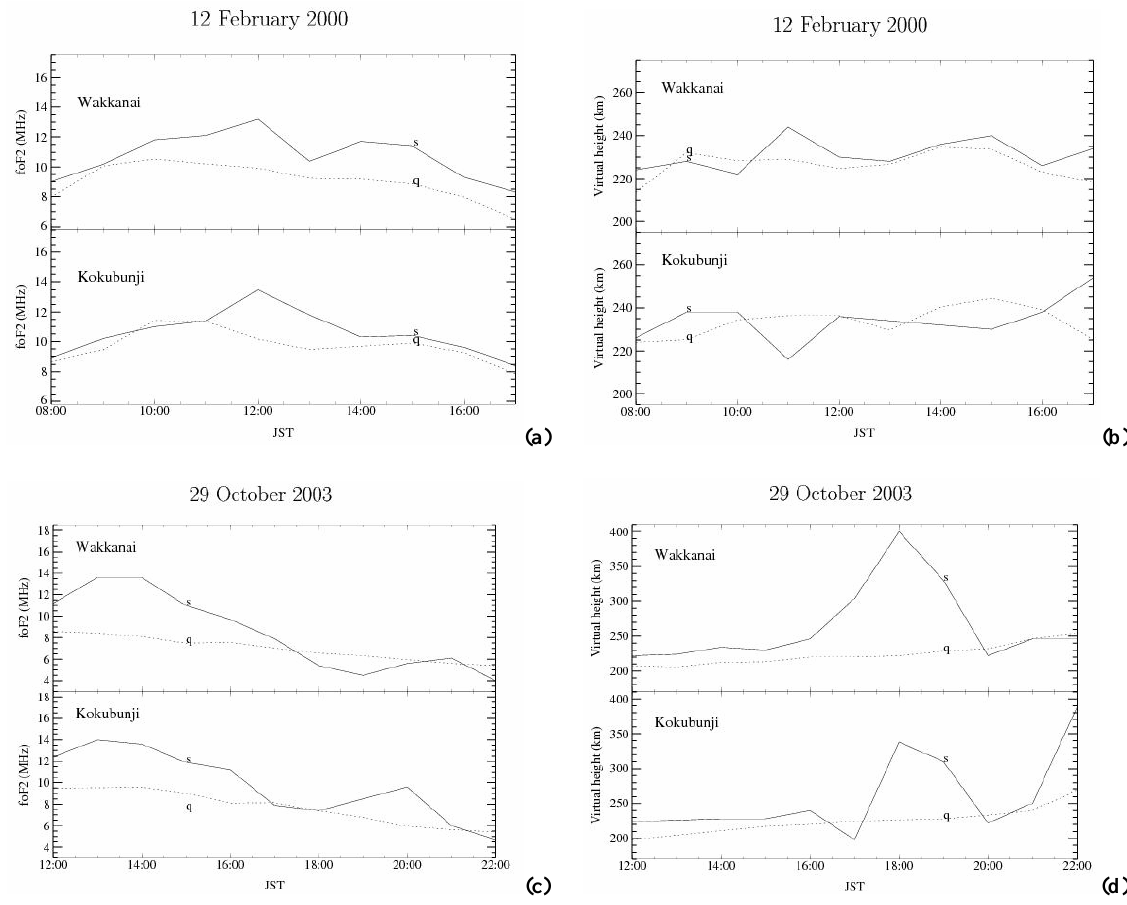
Fig. 5. Temporal variations of (a) fo F2, and (b) F-layer virtual height on 12 February 2000 (continuous line with a marking “s”) compared to the quiet-time values (dotted line with a marking “q”) observed by ionosonde data at Kokubunji (35.7 ◦ N, 139.5 ◦ ,E), and Wakkanai (45.4 ◦ N, 141.7 ◦ E). Also, those of (c) fo F2, and (d) F-layer virtual height on 29 October